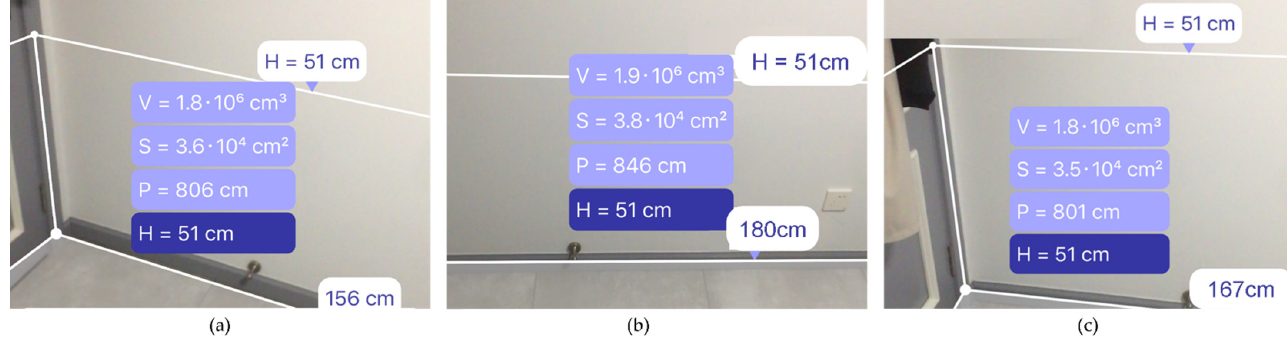
Figure 7 . The process of capturing the virtual elevation between the connection point and any 3D plane in space. There are two sorts of field of view limits snapping in MAR. The first is that the user cannot see the snapping result of actual or virtual object on the ground at a distance. The other is that the user cannot see the snapping results outside his field of vision. In this study, a combination of marker bars and ground circles is employed to assist produce a distance-related viewer effect in the first issue. Figure 8 shows two sets of marker bars and ground circles at varying distances. With real-time rendering of marker bars and ground circles, snapping information at various places is constantly user-facing and highlighted. The size change of the ground circle provides an effective perception of the snapping dis- tance. The marker bar model, which is always vertically oriented and whose size is